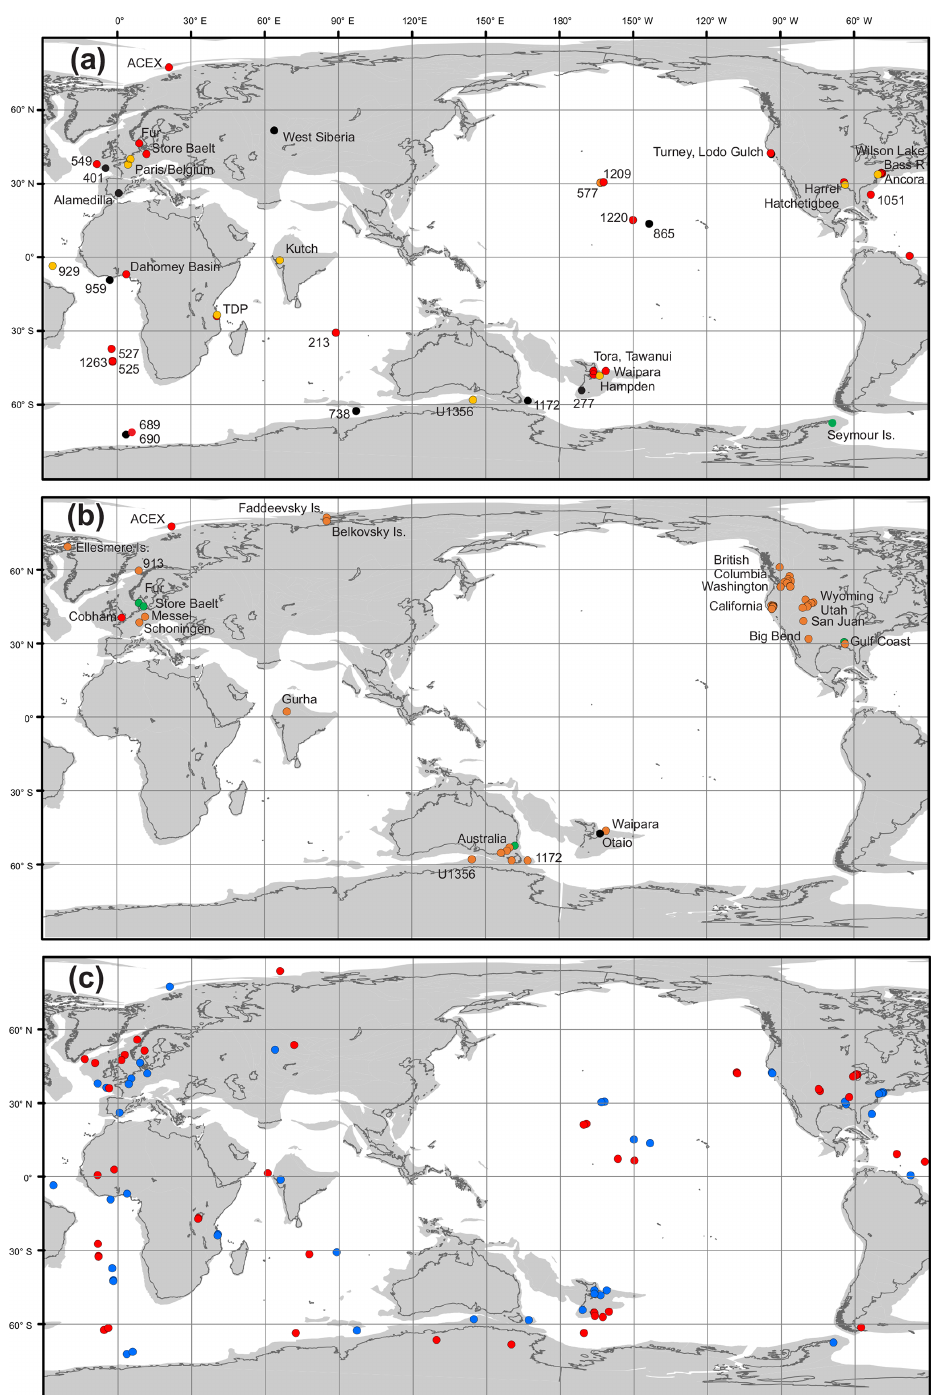
Figure 7. Sites with latest Paleocene–early Eocene temperature estimates on a 52Ma paleogeographic reconstruction using relative plate motions from Matthews et al. (2016) with the paleomagnetic reference frame of Torsvik et al. (2012). (a) Marine sites with time intervals indicated as follows: black circles, all three time intervals represented; red circles, PETM ± LP intervals; orange circles, EECO interval; green circle, middle Eocene (Seymour Island). (b) Terrestrial sites with time intervals indicated as in (a) and green circles, LP only. (c) Comparison between reference frames; blue circles are marine sites plotted using the same paleomagnetic reference frame as in (a) ; red circles are plotted using a moving hot-spot reference frame (Matthews et al., 2016). Site locations and paleolocations are tabulated in Supplement Data File